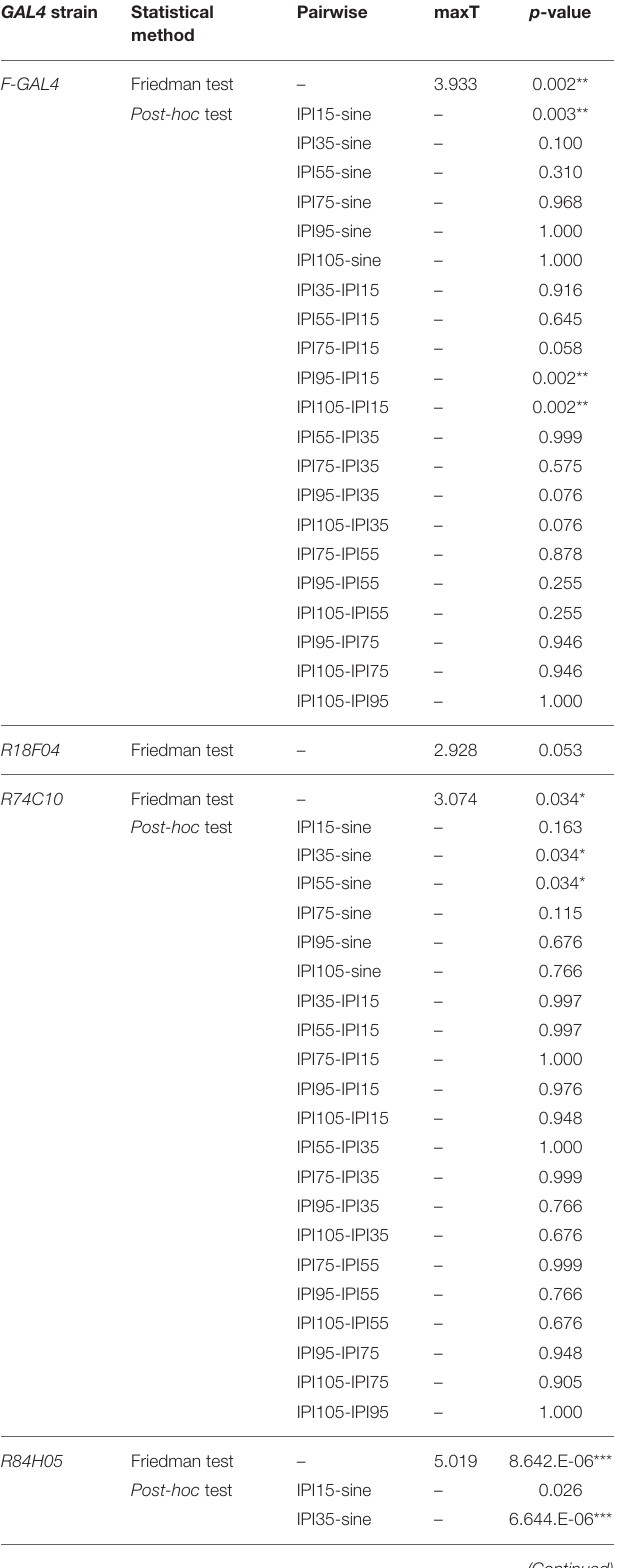
TABLE 6 | Statistical comparison of Ca 2 + response among various